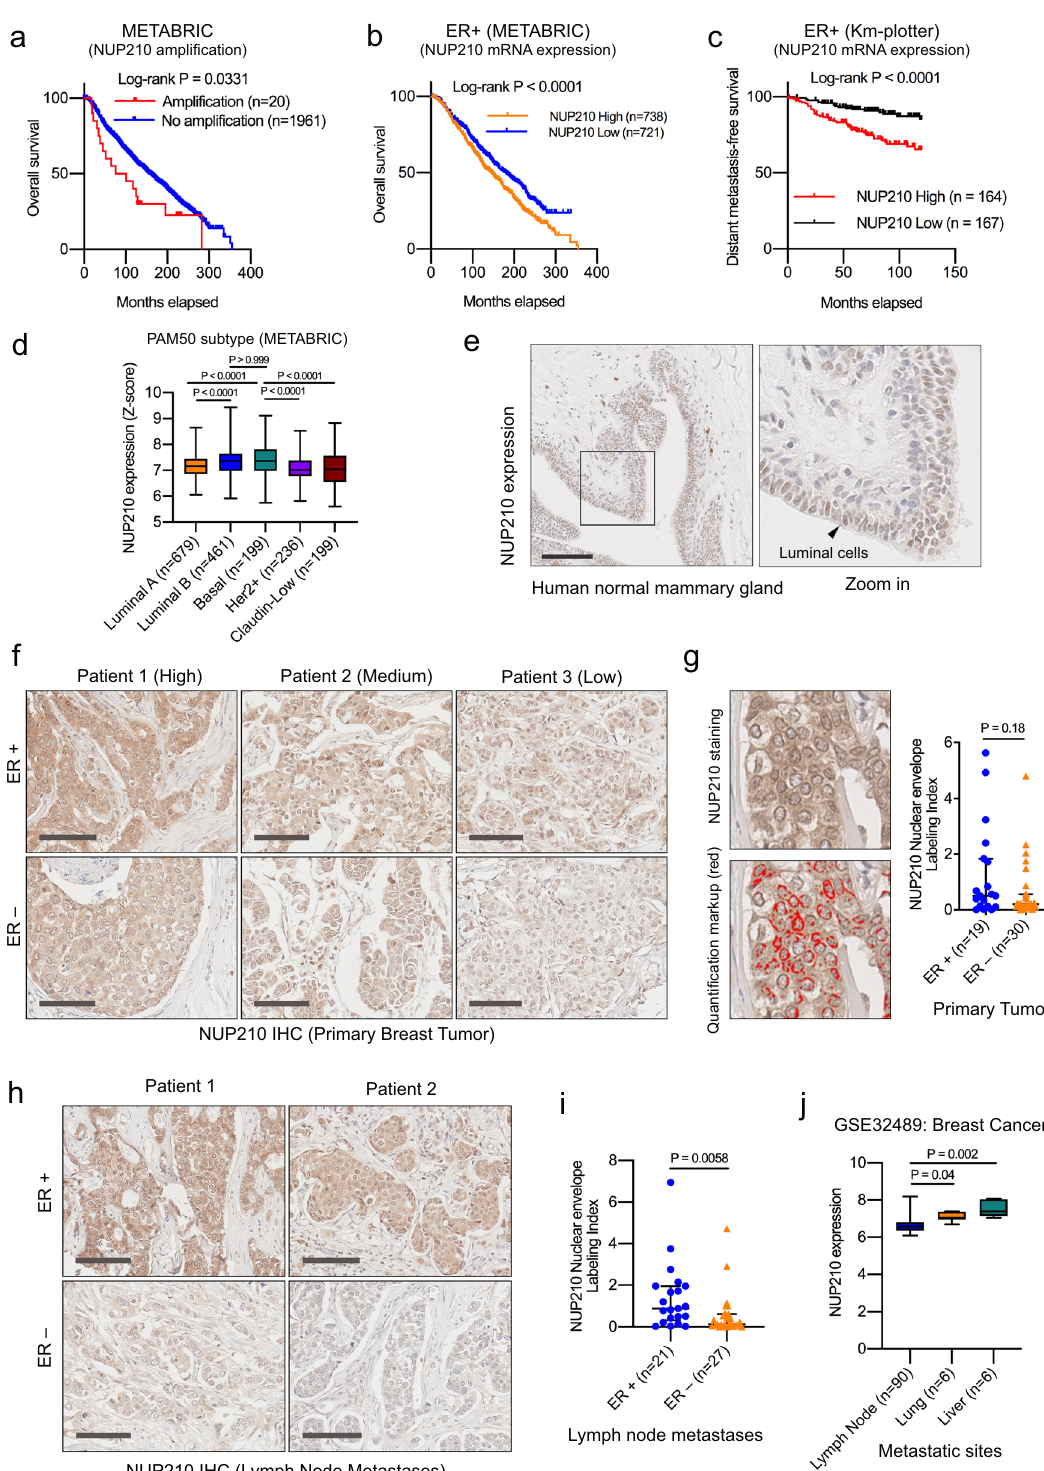
(Supplementary Fig. 5a, b). These results establish an evolutio- narily conserved association of NUP210 with H3.1/3.2 in mouse and human